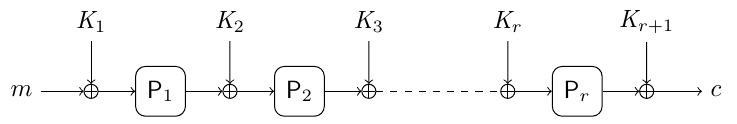
Figure 1: The r -round iterated Even–Mansour